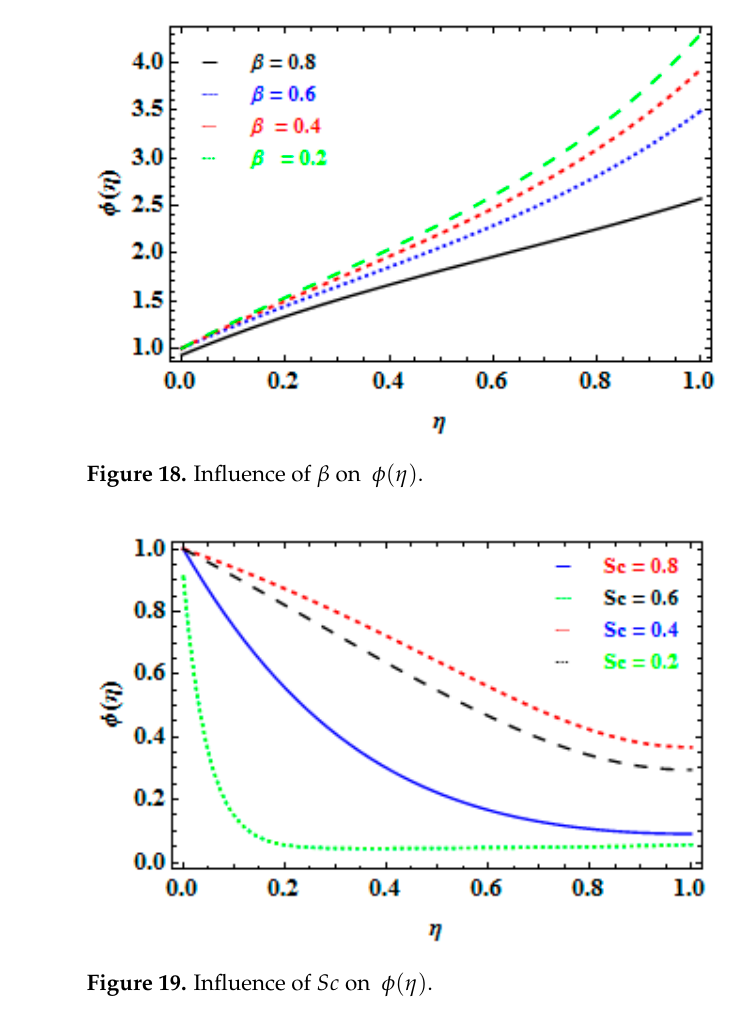
Figure 19. Influence of S c on 𝜙 ( 𝜂 ) .